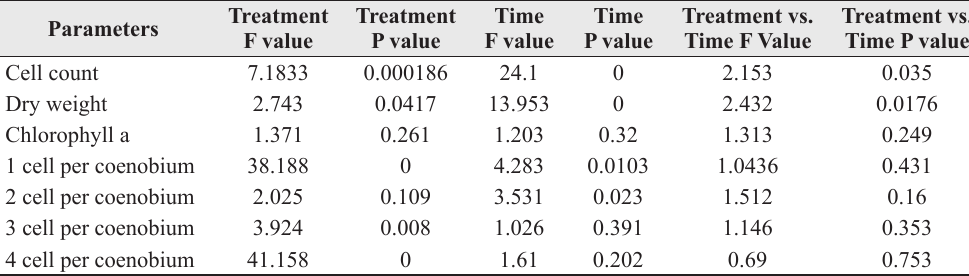
ANOVA summary results for the various parameters of Scenedesmus quadricauda analyzed after exposure to different dye effluent concentrations. N.B: where P value is less than 0.05, the ANOVA F value is